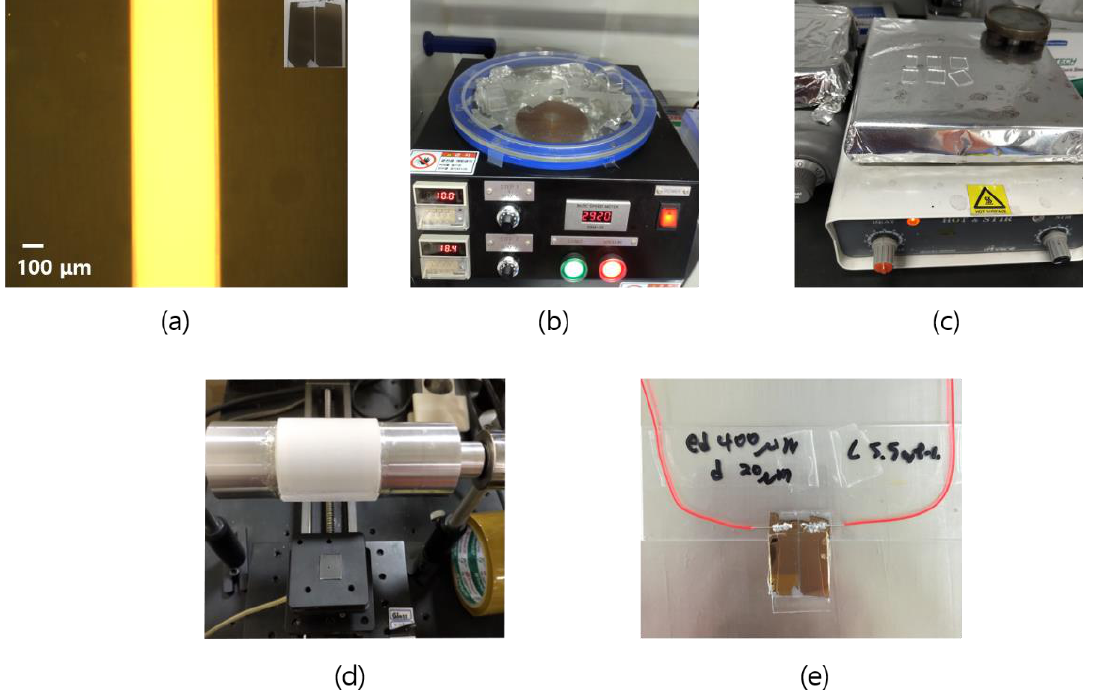
Figure 1. Fabrication process of the CLC cell; ( a ) electrode substrates, ( b ) spin coating, ( c ) baking, ( d ) rubbing and ( e ) the fabricated CLC cell.